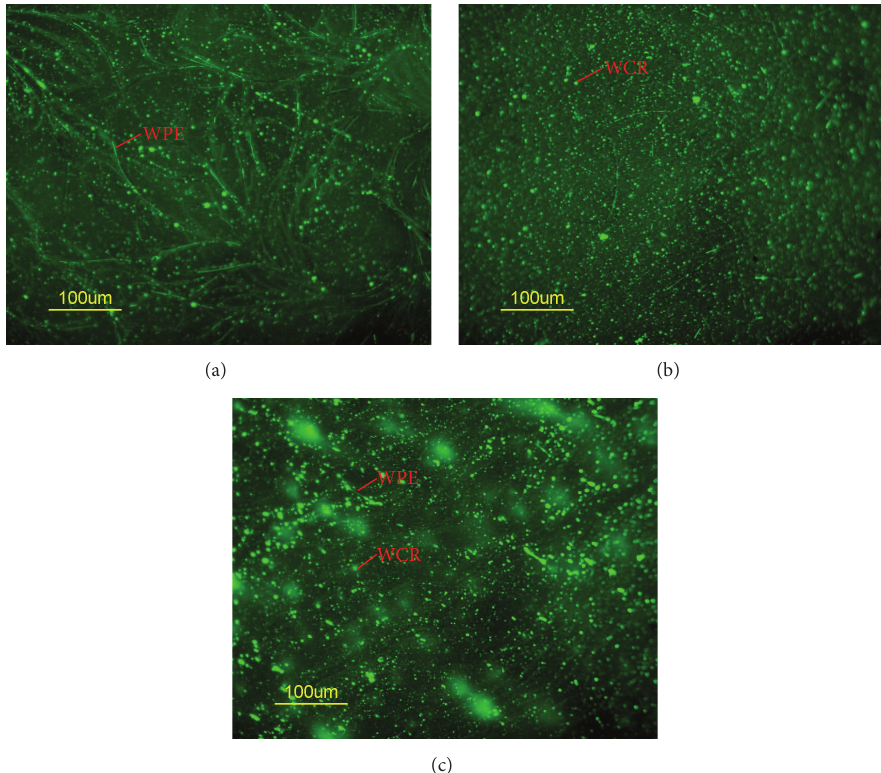
Figure 6: Fluorescence microscope pictures of modified asphalt: (a) asphalt modified by 4 wt% WPE, (b) asphalt modified by 3 wt% WCR, and (c) asphalt modified by 4 wt% WPE + 3wt%